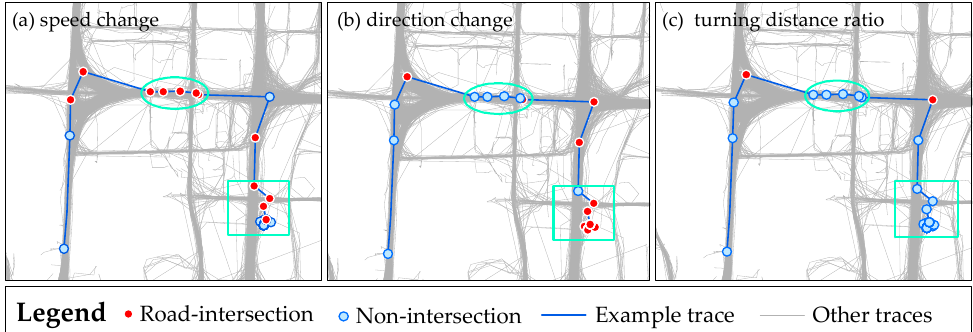
Figure 5. Three indicators of speed change, direction change and turning distance ratio for category- level segmentation: ( a ) speed charge, ( b ) direction change and ( c ) turning distance ratio.